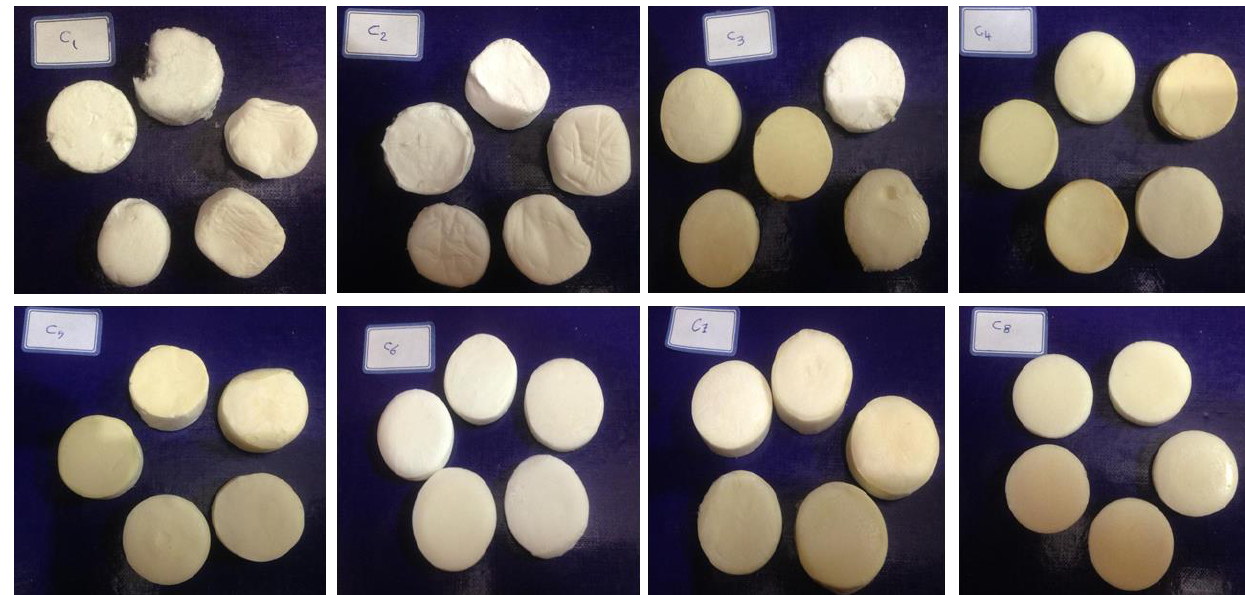
Figure 2. Digital photographs of samples